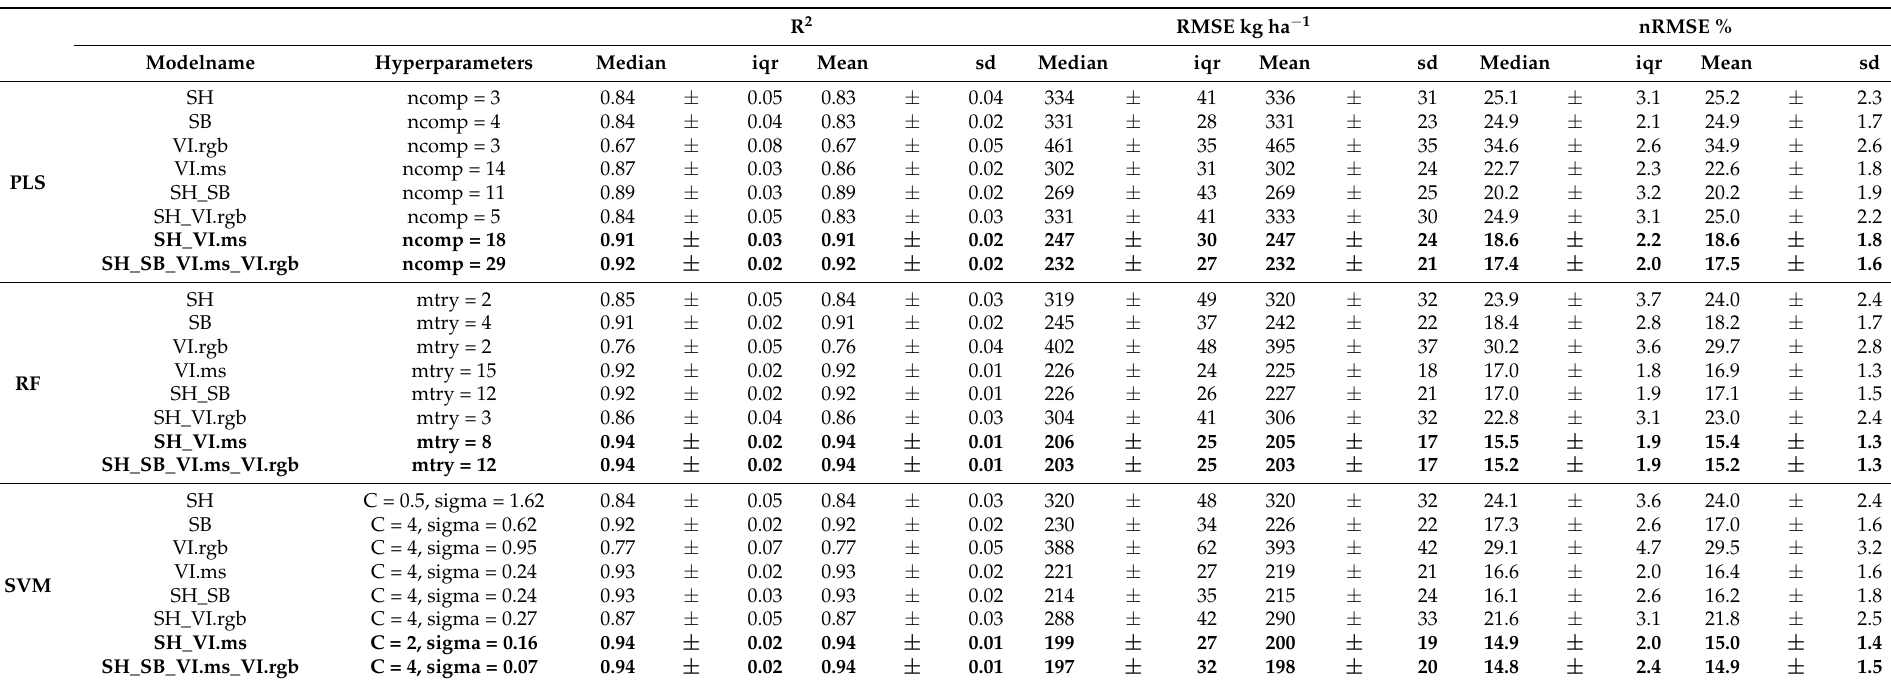
Table A2. Cross-validation results for DMY estimation using PLS, RF and SVM regression (nRMSE normalized via mean observed value). Bold highlights indicate two best models per algorithm. iqr: interquartile range, sd: standard